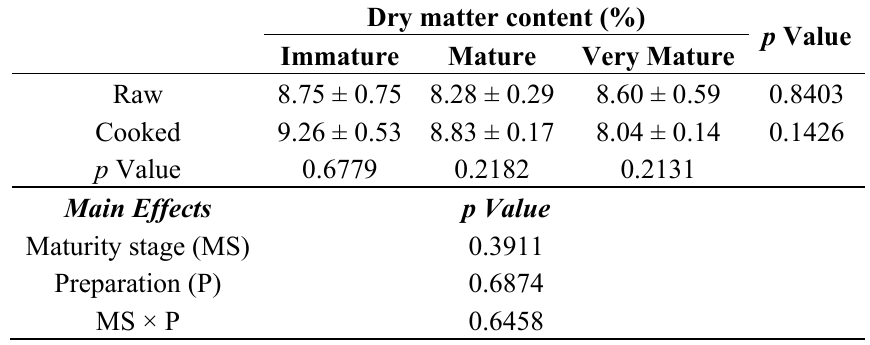
Table 3. Dry matter content (%) of raw and cooked winter squash pulp in three stages of